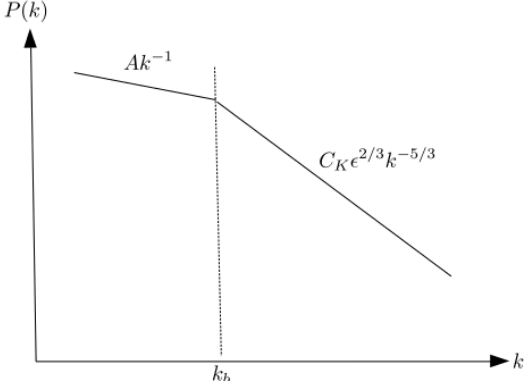
Figure 5. Schematic diagram of the power spectral density P ( k ) of Elsässer energies (cid:104) z + 2 (cid:105) , turbulent magnetic energy density E b , and the turbulent kinetic energy (cid:104) u 2 (cid:105) as a function of wavenumber k , illustrating the energy-containing range and the inertial range. The parameter k b is a spectral break wavenumber, which separates the energy-containing range and the inertial